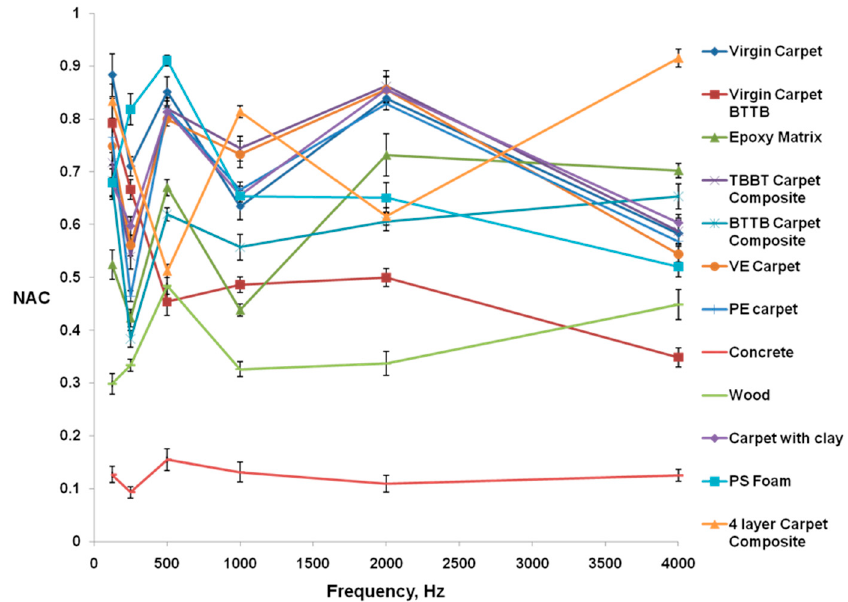
Figure 8. Noise absorption coefficients of various noise absorbing materials calculated at the third-octave band range of frequencies using ASTM C 384-04.